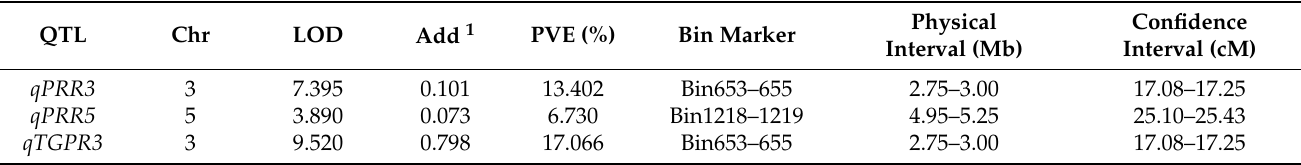
Figure 3. Chromosomal locations of the QTLs. Table 1. QTLs identified from the analysis of rice